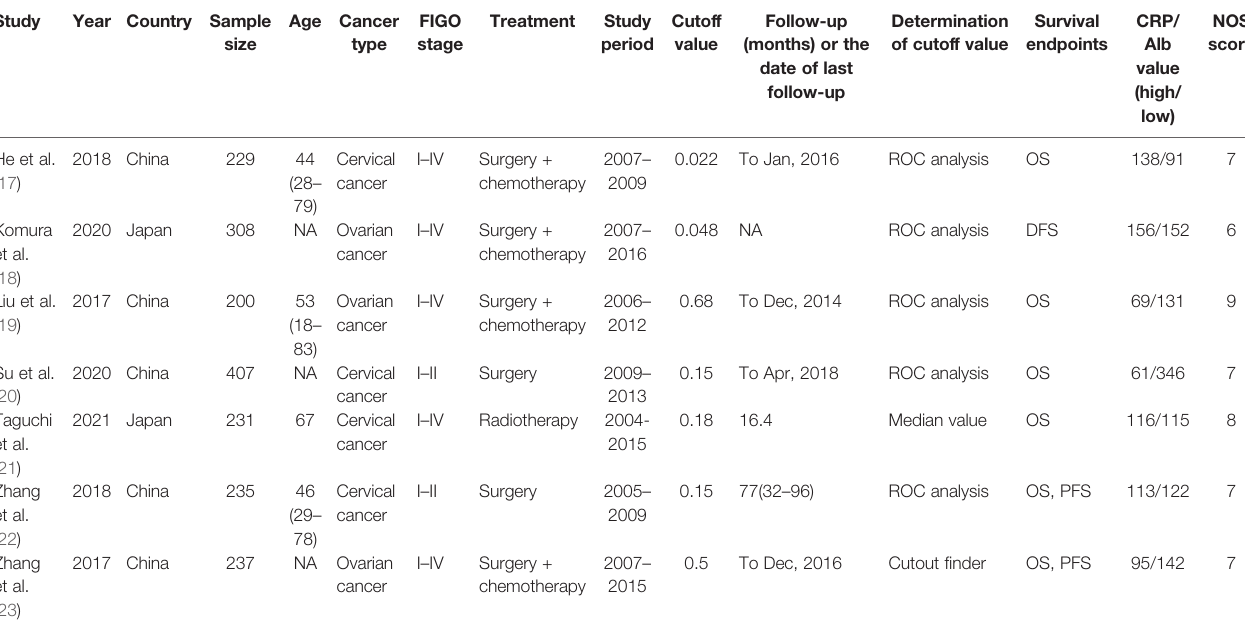
FIGO, International Federation of Gynecology and Obstetrics; NA, not available; OS, overall survival; PFS, progression-free survival; DFS, disease-free survival; ROC, receiver operating characteristics; NOS, Newcastle-Ottawa Scale; CRP/Alb, C-reactive protein/albumin ratio.